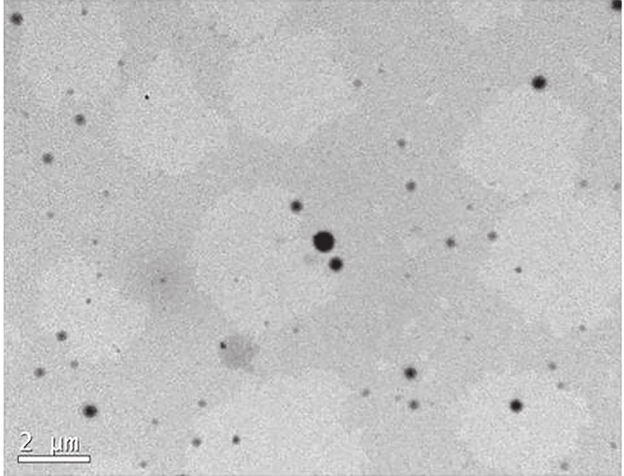
FIGURE 1 – TEM micrograph of PCL nanoparticles containing thyme essential